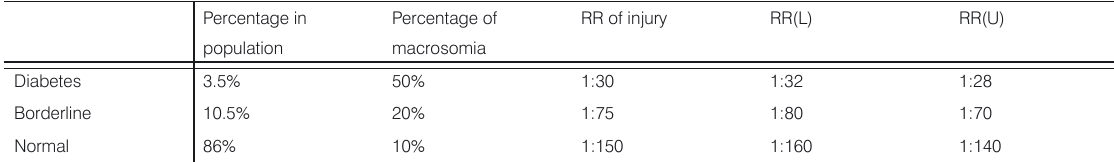
newborns are macrosomic, they accounted for